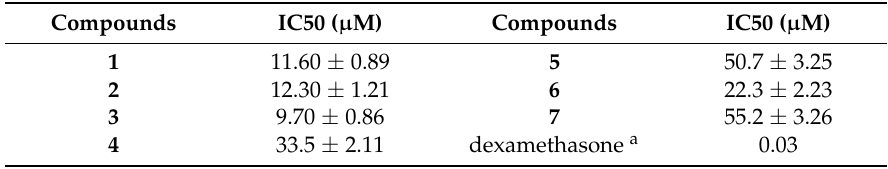
Table 3. Inhibitory effects of compounds against LPS-induced NO production in mouse BV2 microglial cells ( n =